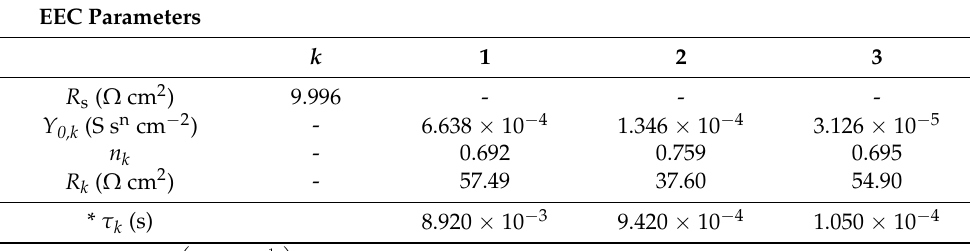
Table 4. Final EEC parameter values obtained by EEC R(QR)(QR)(QR) and both the ordinary and automatic update limit strategies. The values were obtained by fitting the ZARC data (Figure 2).